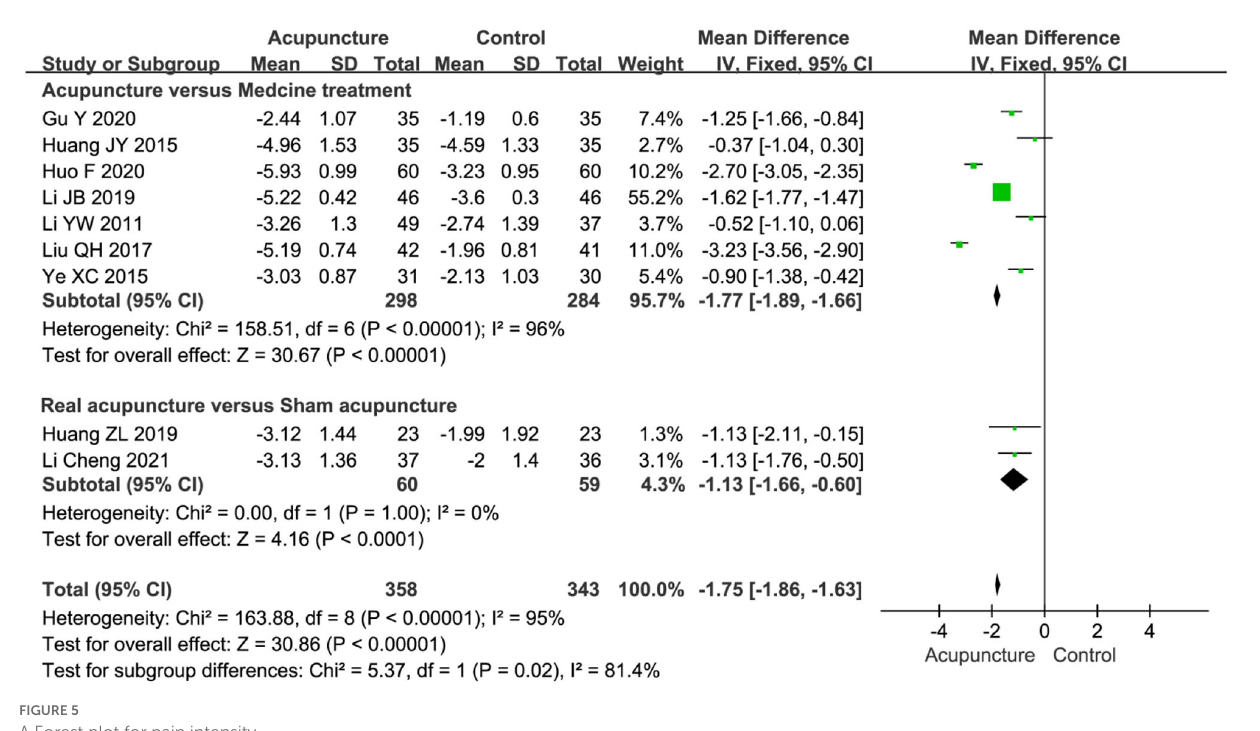
FIGURE5 A Forest plot for pain intensity.